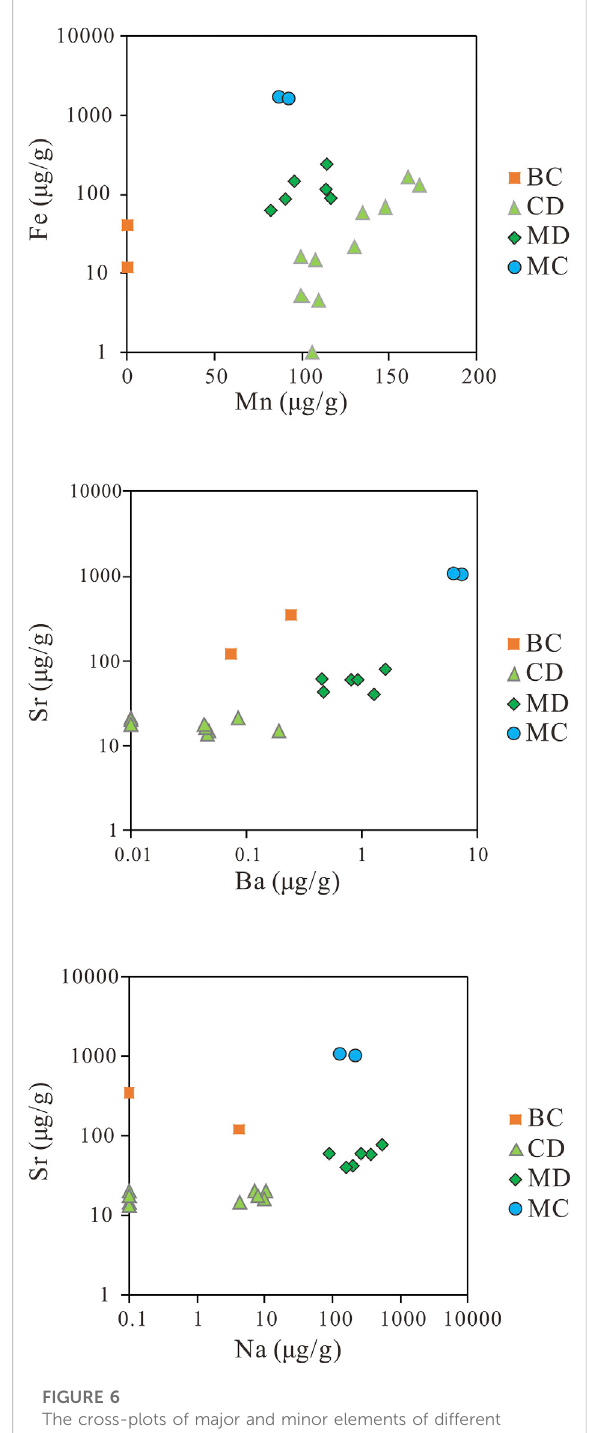
FIGURE 6 The cross-plots of major and minor elements of different types of dolomites in the Xiaoerbulake Formation of well